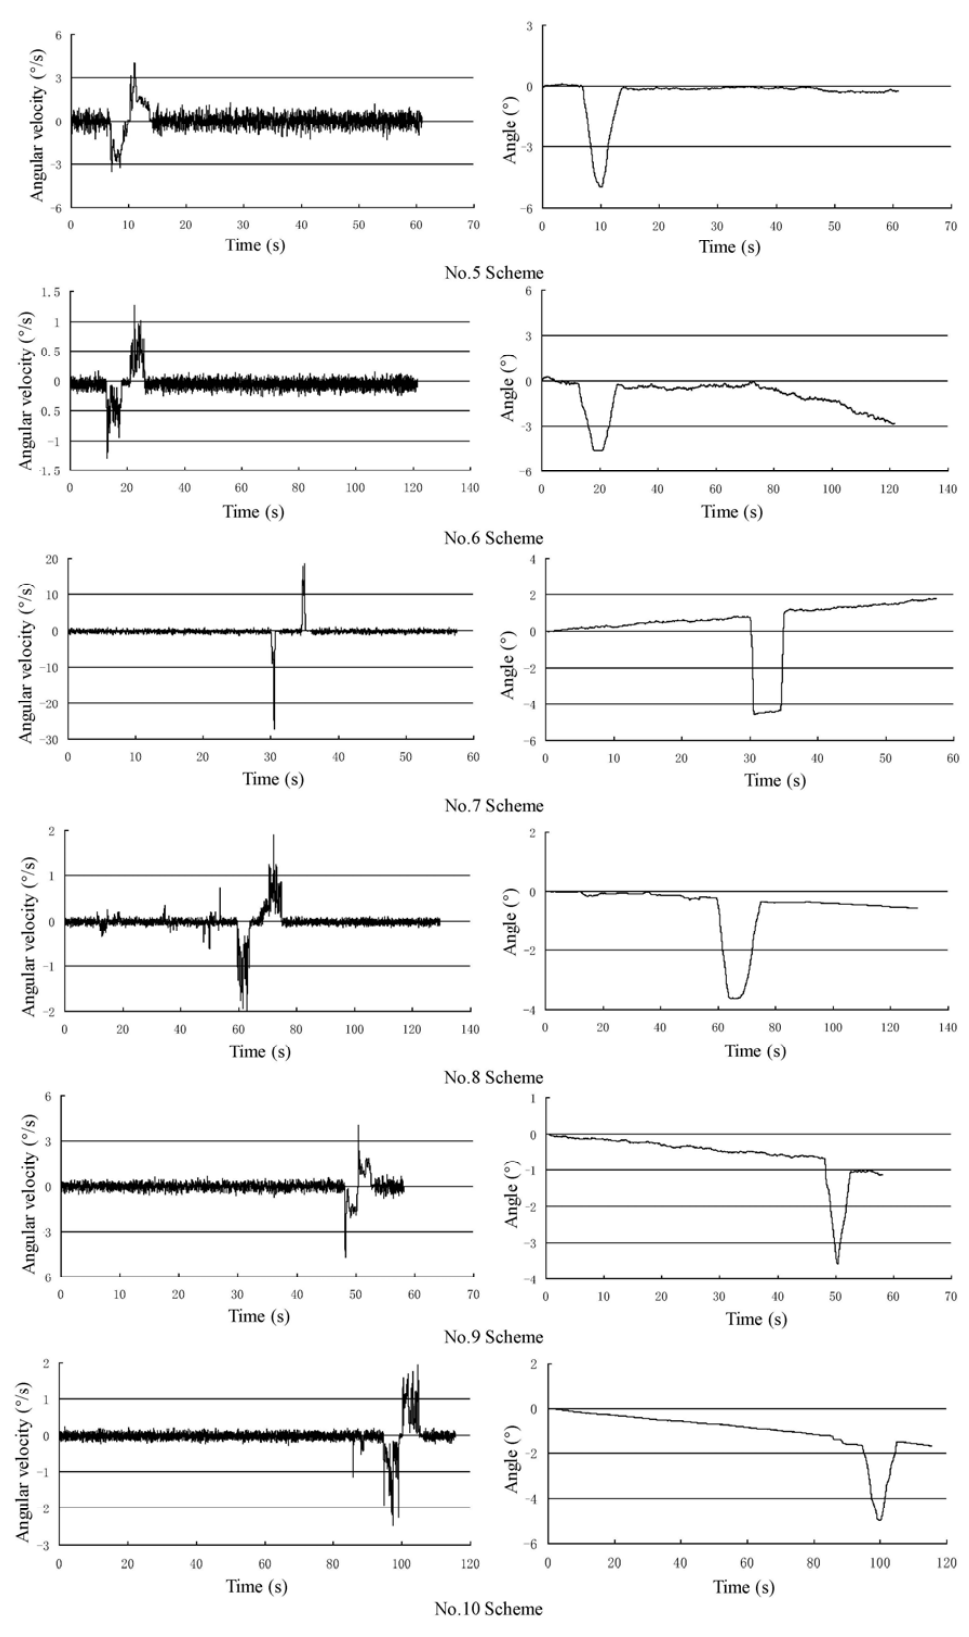
Figure 9. Angular velocity curves and the heading angle curves after